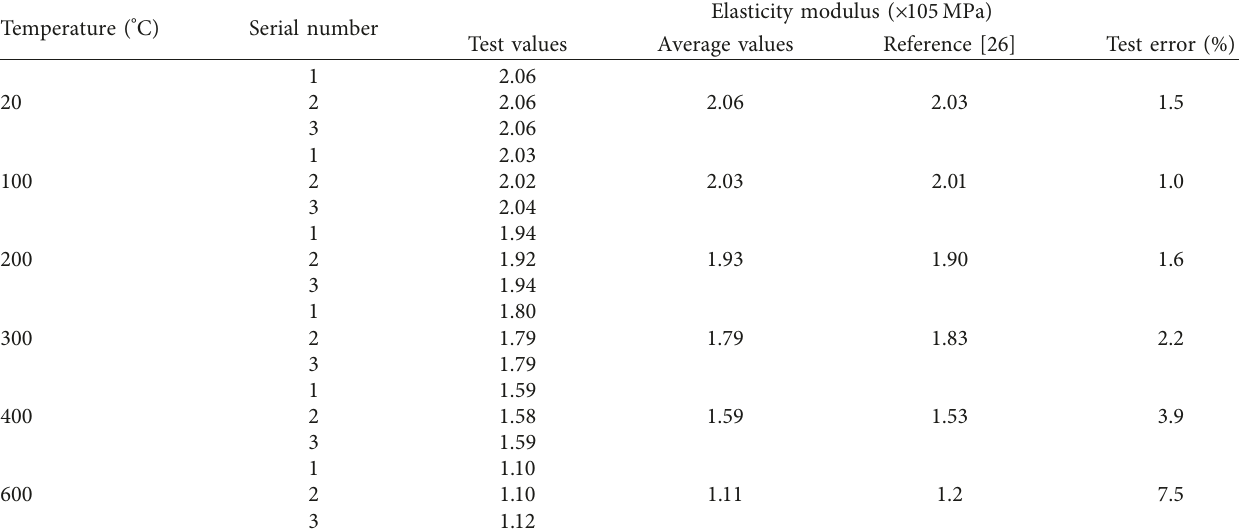
Table 2: Test values of the modulus of